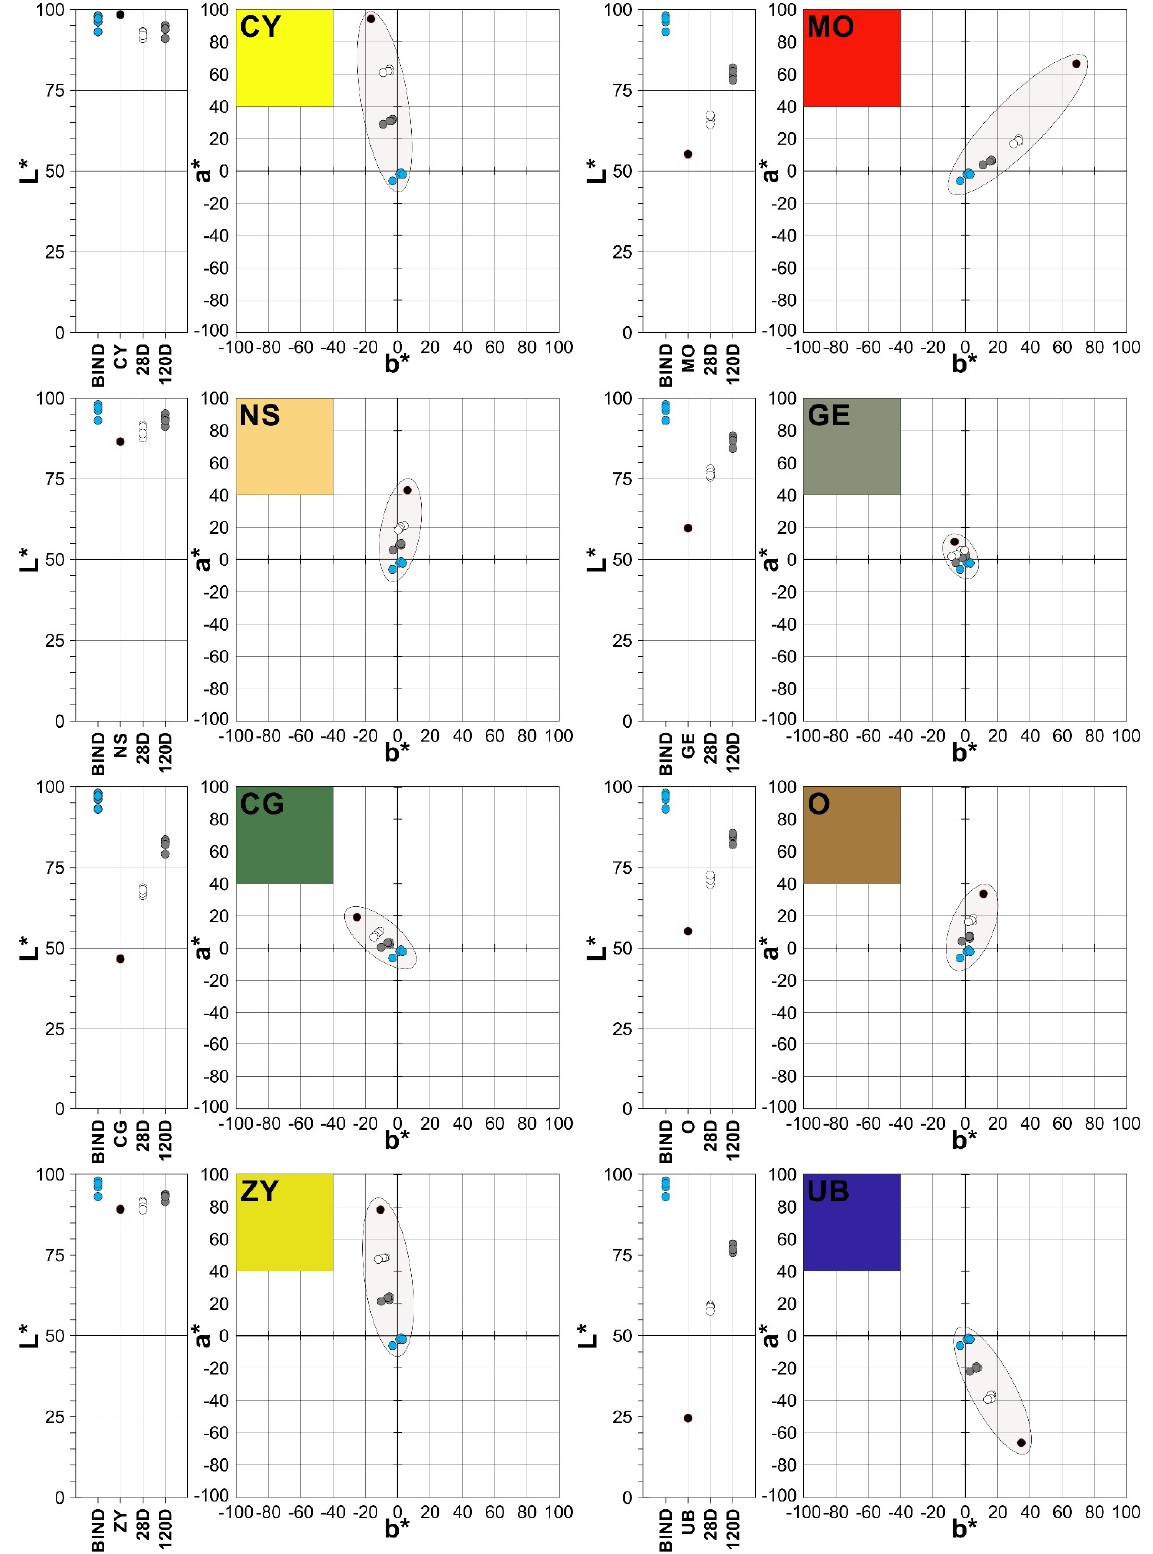
Figure 6. CIELab1976 colour space representation of binders and their corresponding pigment-coloured pastes (PPS, PALS, PHLS and PWGS). Plot L*, indicates brightness values of the different samples. Plot a*-b*, indicates chromaticity values of the different samples. Blue circles are the binder samples without pigment; black circles are the pigment samples; white circles are the paste samples at 28 days; grey circles are the paste samples at 120